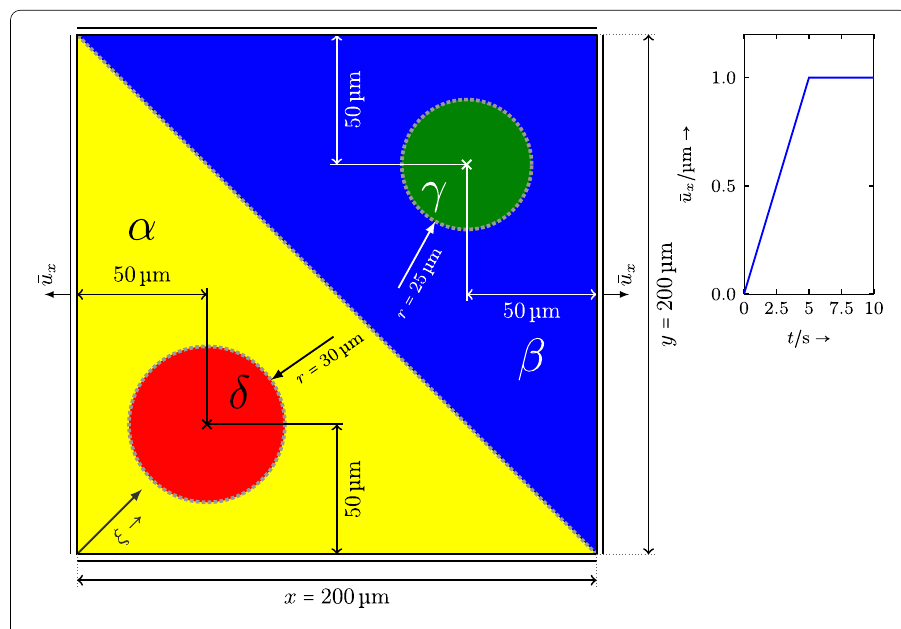
Fig. 13 Setup: 2D plate consisting of two triangular parts with an inclusion each. The x-boundaries are exposed to a variable load (see graph on the right), while the y-boundaries are fixed in y-direction